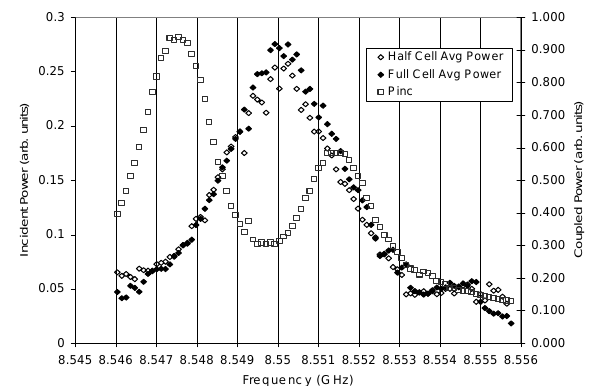
FIG. 3. Power incident upon the gun ( P inc ), and the power in the half and full cells of the gun as measured by the monitor probes and normalized to the incident power.